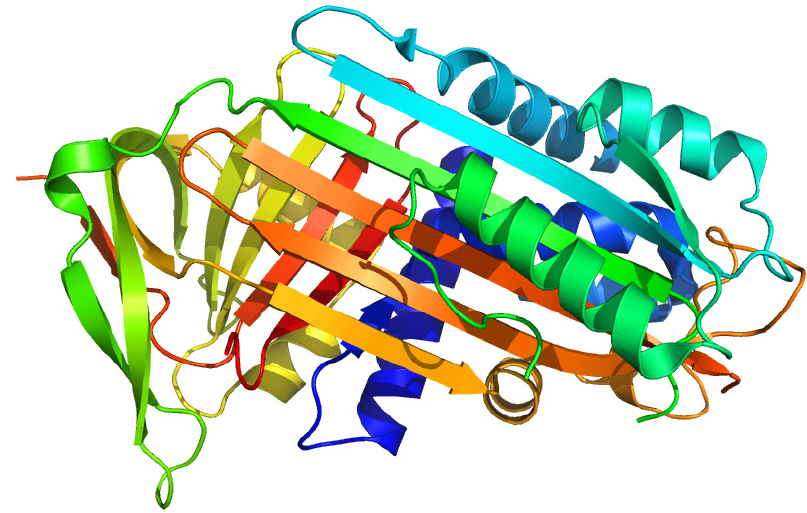
Figure 11. Crystal structures of the human corticosteroid-binding globulin. The illustration was produced by PyMol using the atomic coordinates from the Protein Data Bank, PDB2VDY